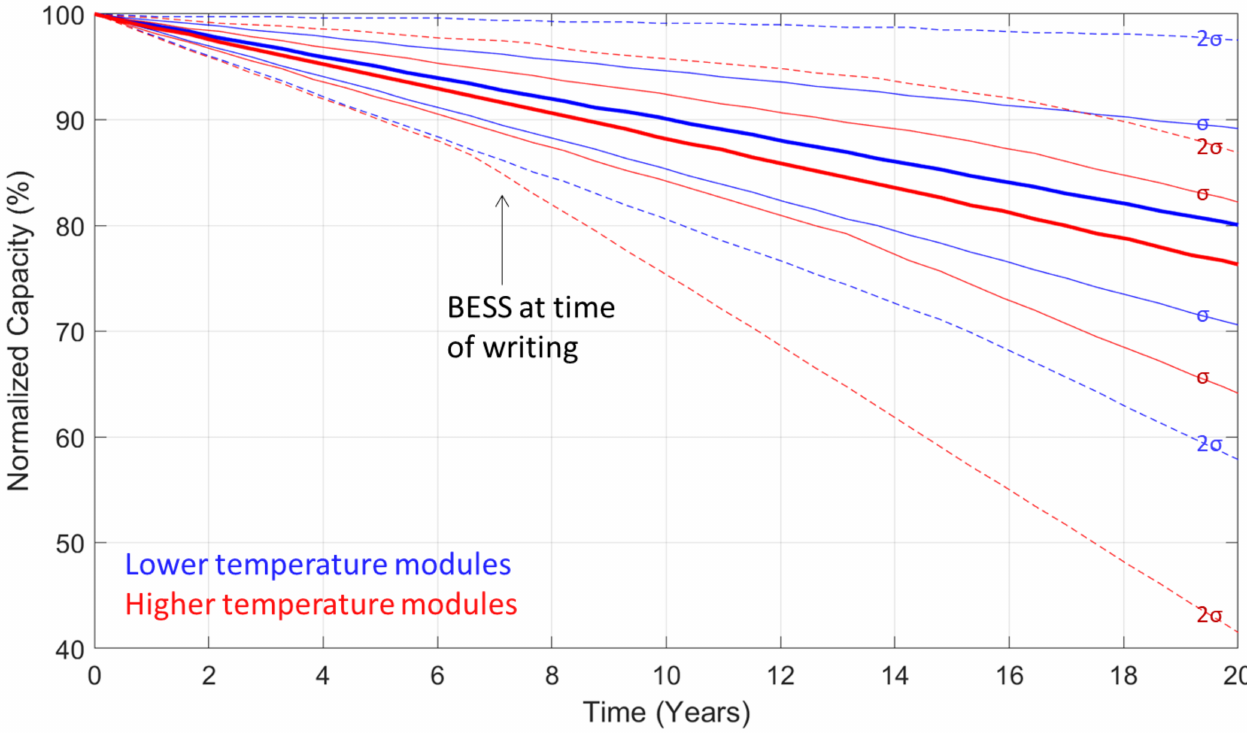
Figure 15. Forecast of capacity loss based on degradation modes extrapolation with ± 3% of the estimation performed around day 1000 on 3 modules believed to be representative of the